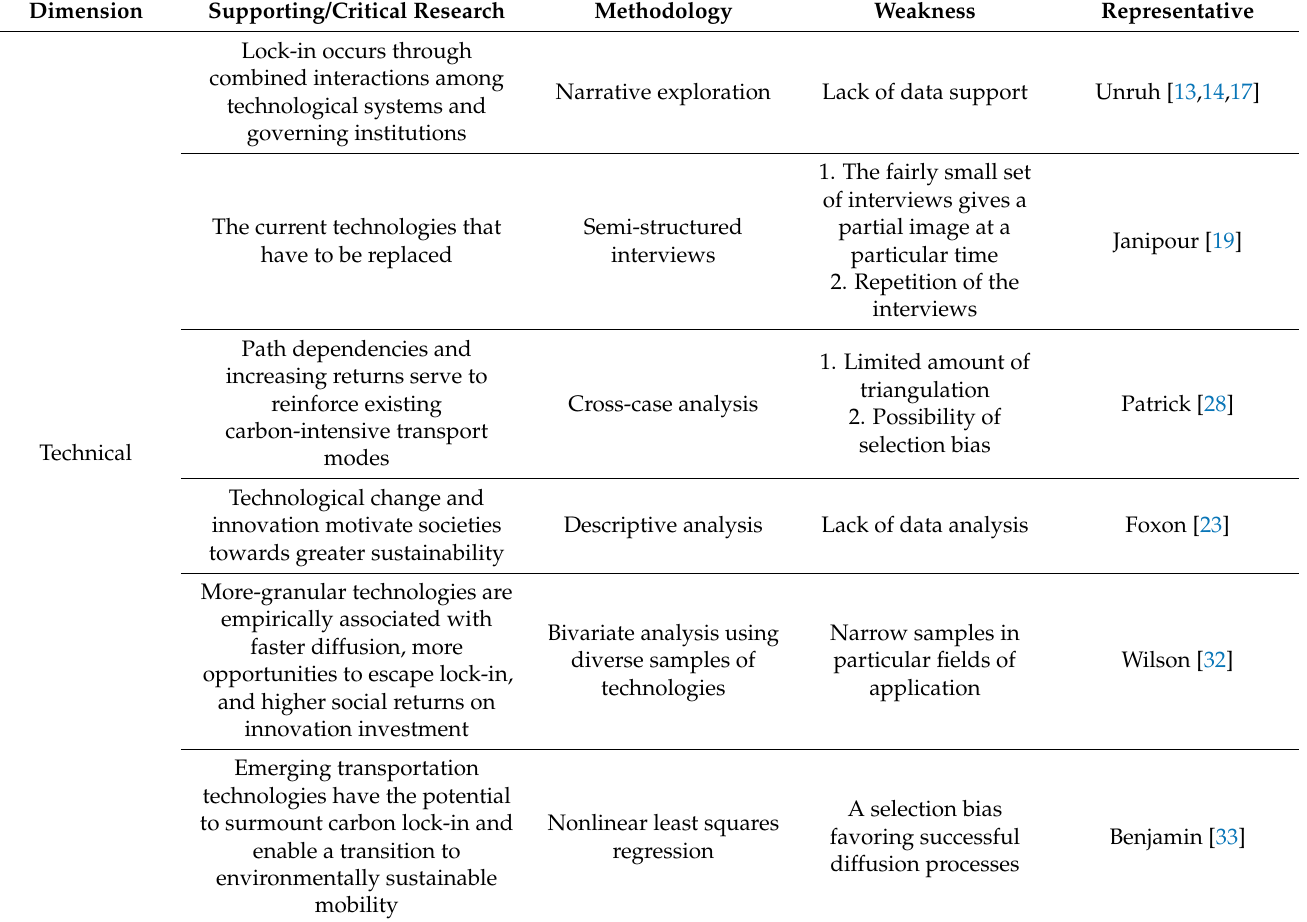
Table 1. Key references with